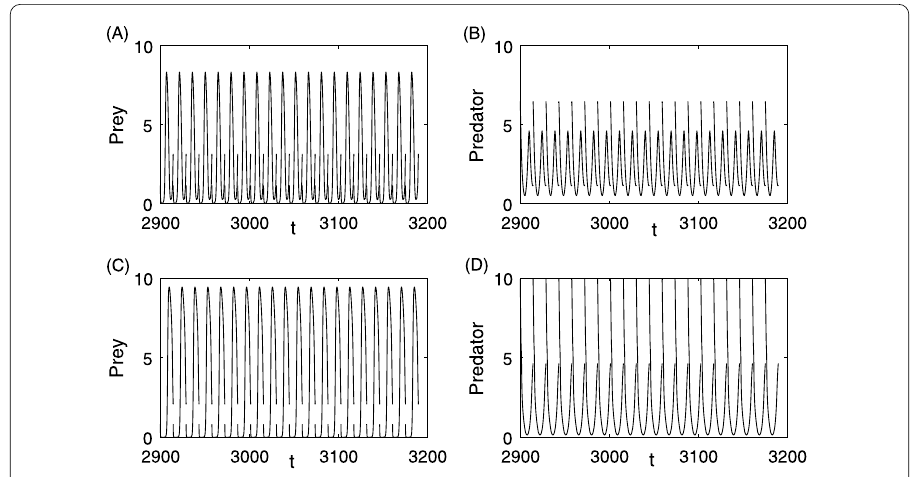
Figure 2 Two coexisting attractors of model (17) with T = 14.5. The other parameter values identical to those in Fig. 1. The initial conditions are: ( A – B )( x 0 , x 0 ) = (3,2.5);( C – D )( x 0 , x 0 ) = (2,3.5)